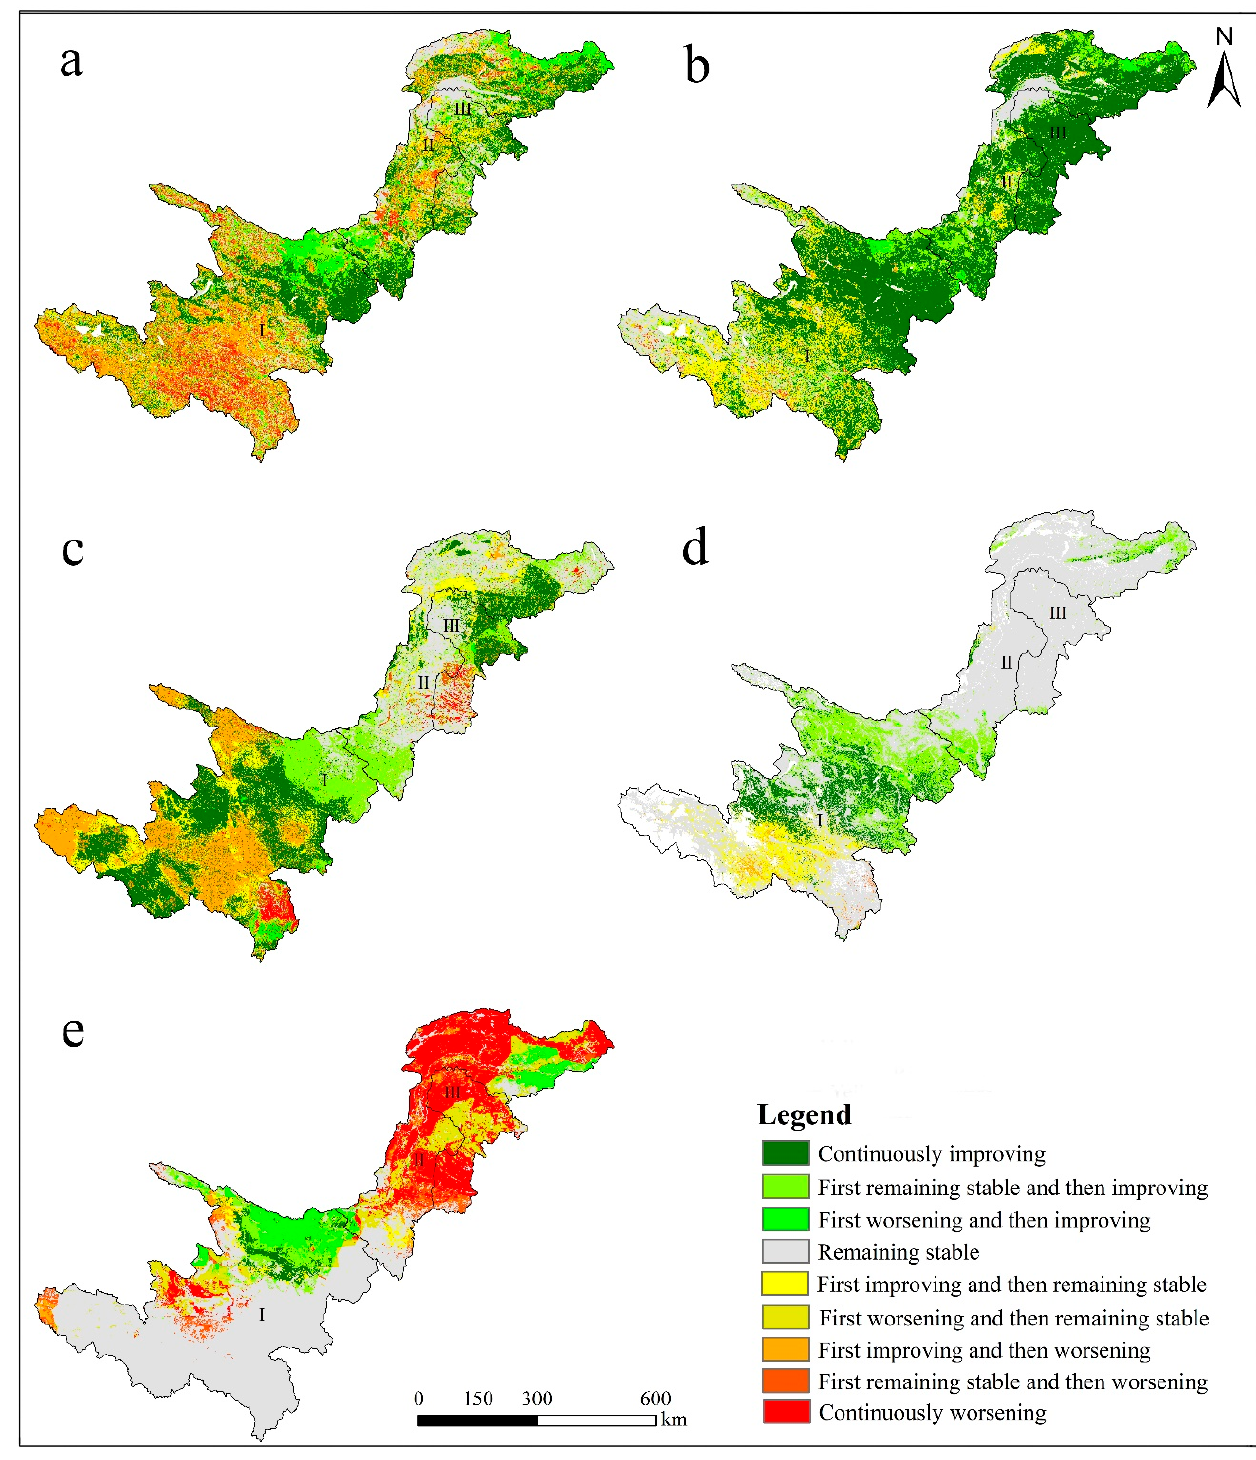
Figure 7. Restoration tendencies of the ecosystem quality and services factors considered herein in the Upper Yellow River region (( a ) FVC, ( b ) NPP, ( c ) water conservation, ( d ) soil conservation and ( e ) windbreak and sand fixation). Compared to that obtained for the 2000–2010 period, the annual mean NPP of veg- etation in the Upper Yellow River increased by 15.6% from 2010 to 2019. In these two periods, the NPP continuously improved in 55.1% of the study area (Table 5). Over the